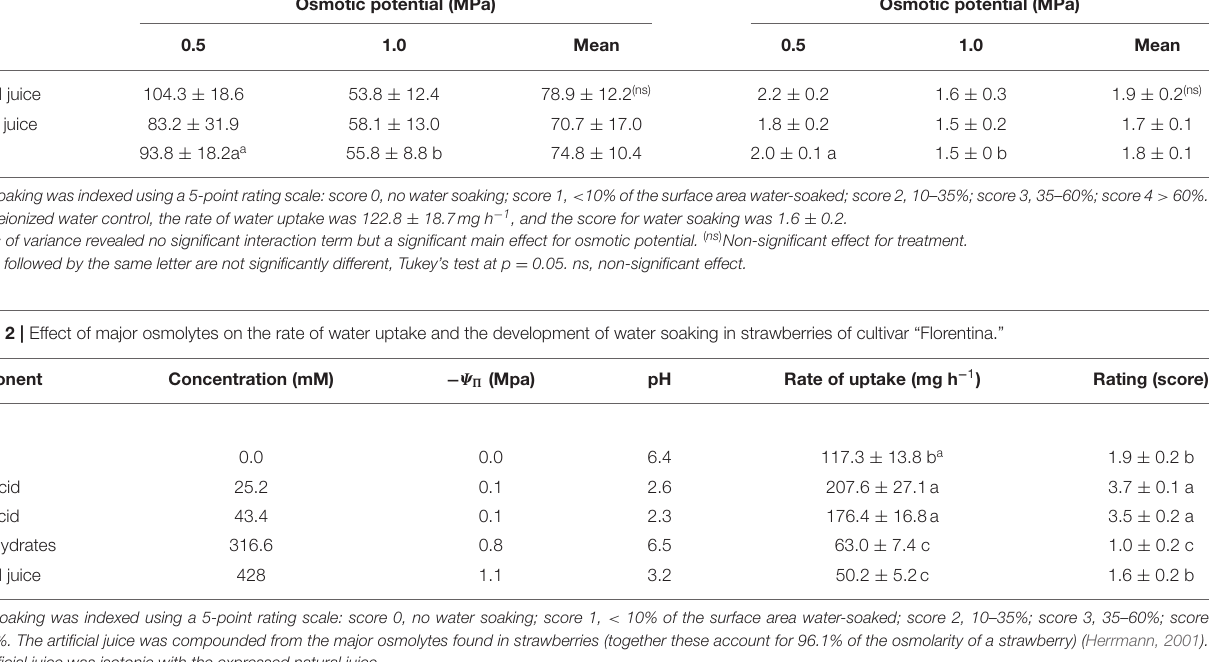
TABLE 1 | Effect of natural (expressed) juice and artificial (compounded) juice on development of water soaking in “Faith” strawberry. Treatment Water uptake (rate, mg h –1 ) Water soaking (score, arbitrary)